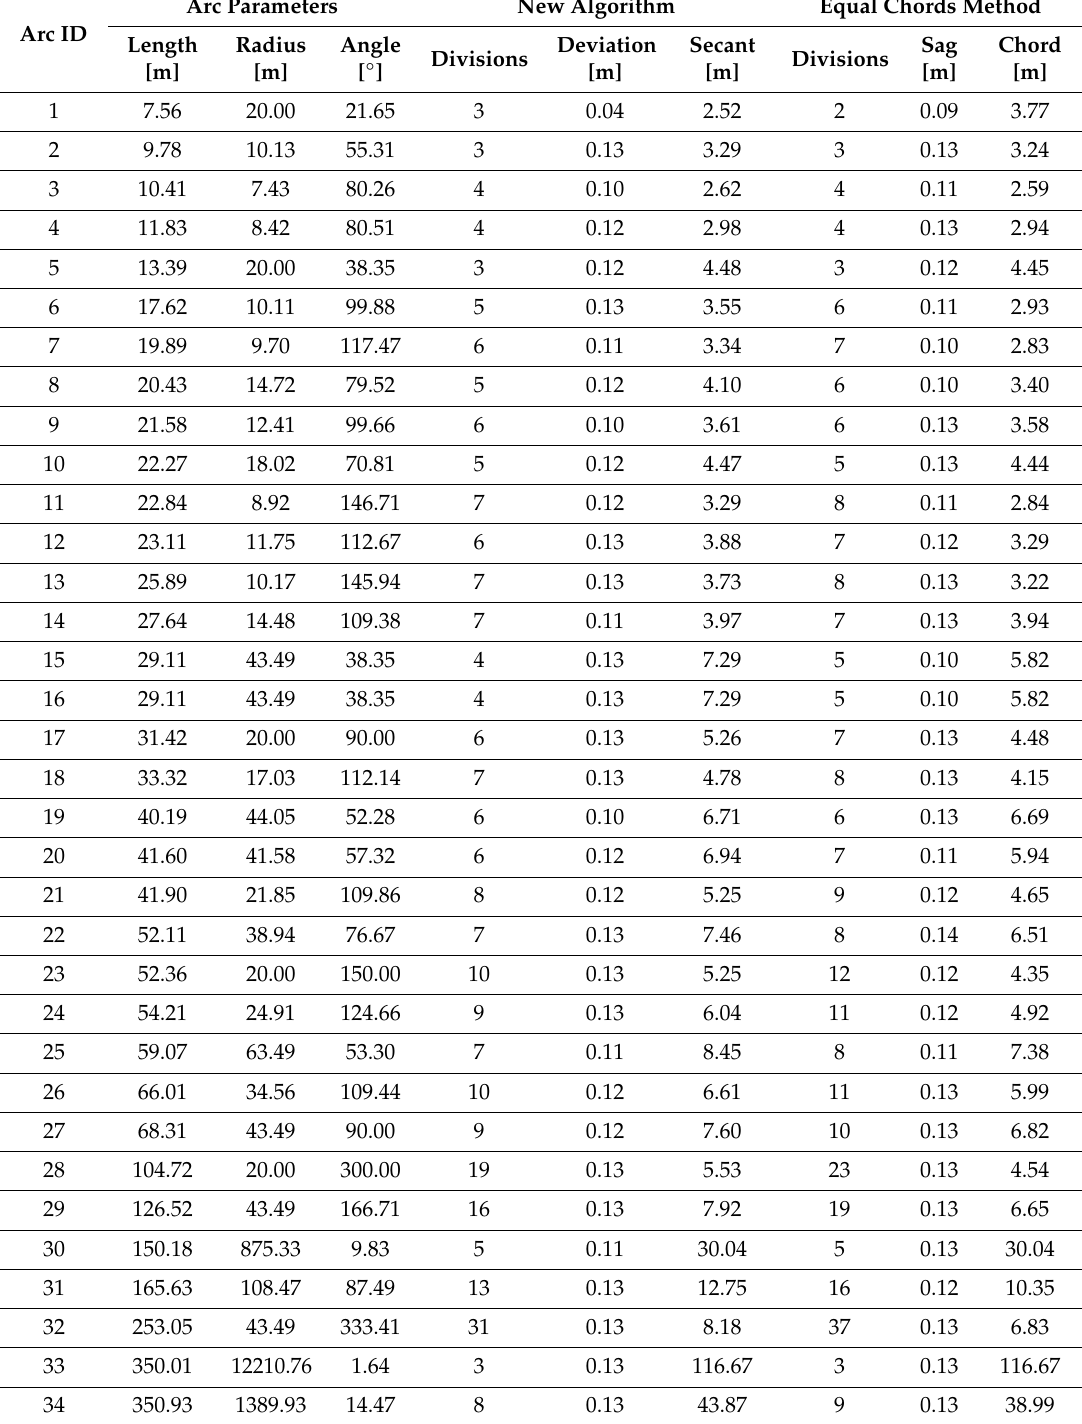
Table 1. Summary of arc parameters and received linear data after approximation (Figure